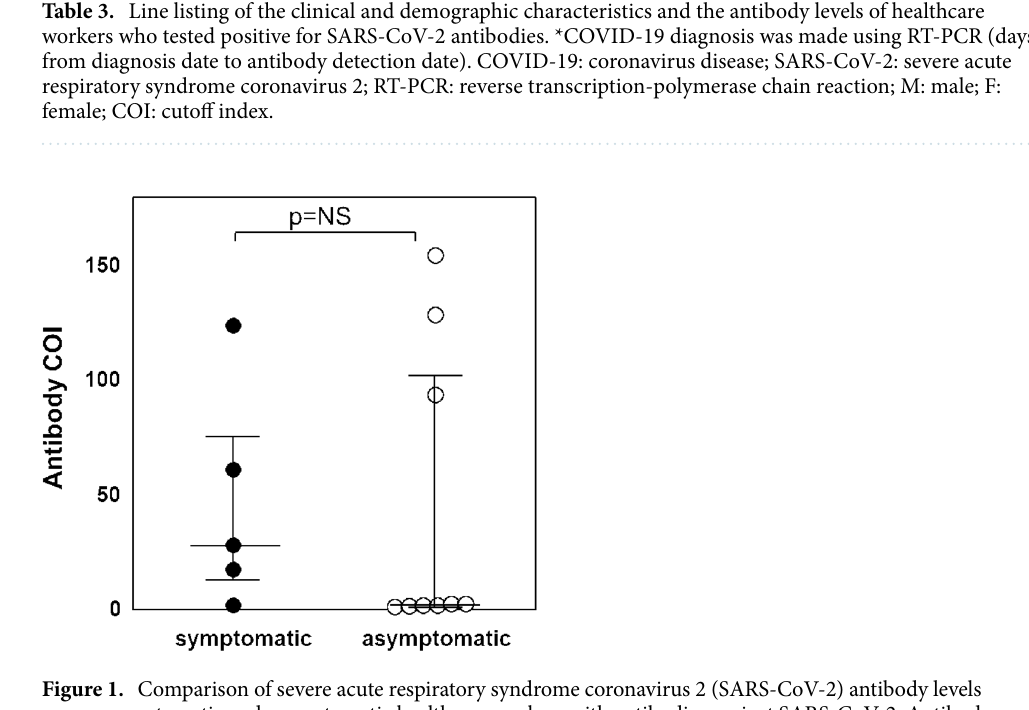
Figure 1. Comparison of severe acute respiratory syndrome coronavirus 2 (SARS-CoV-2) antibody levels among symptomatic and asymptomatic healthcare workers with antibodies against SARS-CoV-2. Antibody levels were quantified using the anti-SARS-CoV-2 antibody index (cutoff index, COI) in participants who had a positive result in the Elecsys Anti-SARS-CoV-2 electrochemiluminescence immunoassay. A COI of ≥ 1.0 was considered positive. Median values of the COI with lower quartile and upper quartile are shown according to symptom status. The difference in the median antibody level between the symptomatic and asymptomatic groups was not